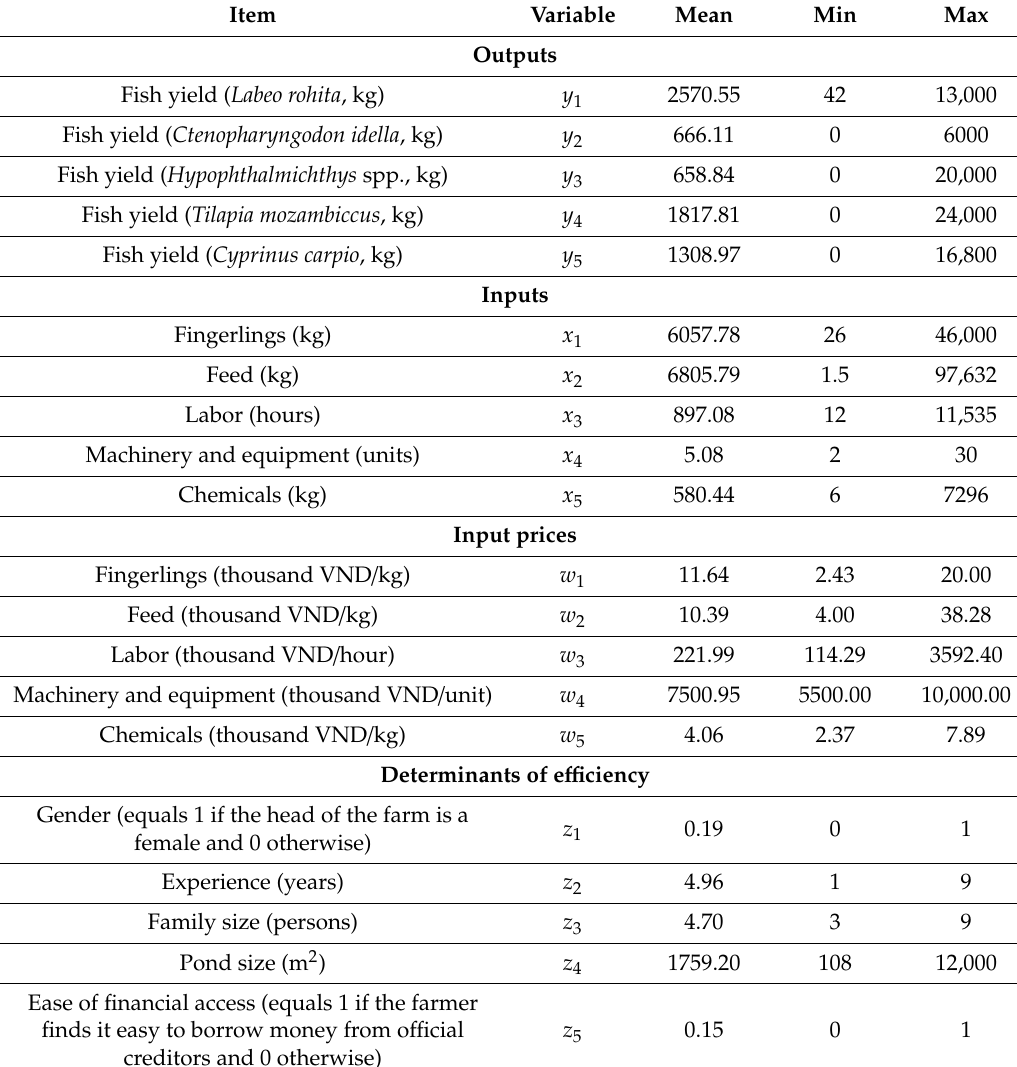
Table 1. Descriptive statistics for variables used in this